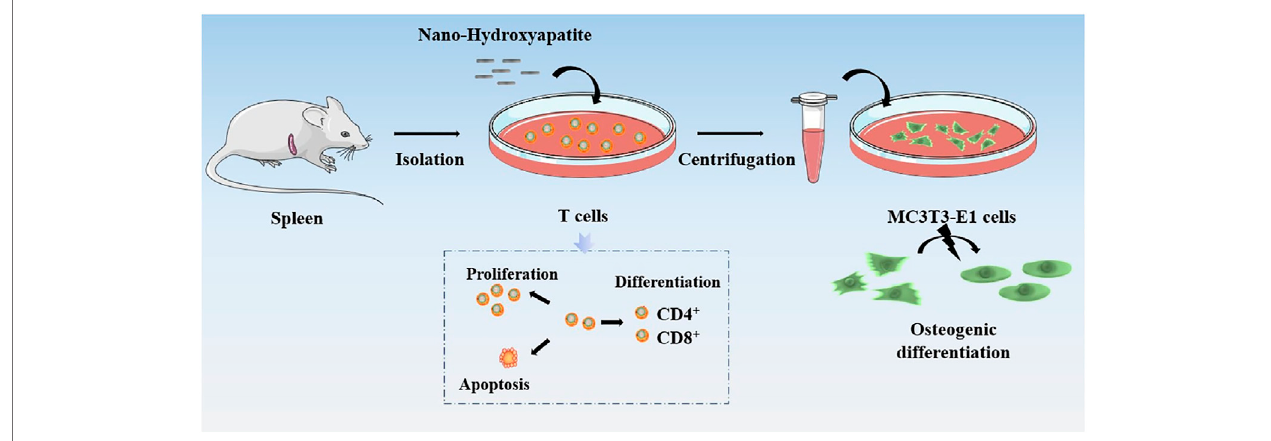
FIGURE 1 | Schematic diagram of the effects of nHA on T cell responses, differentiation, and the following regulatory on